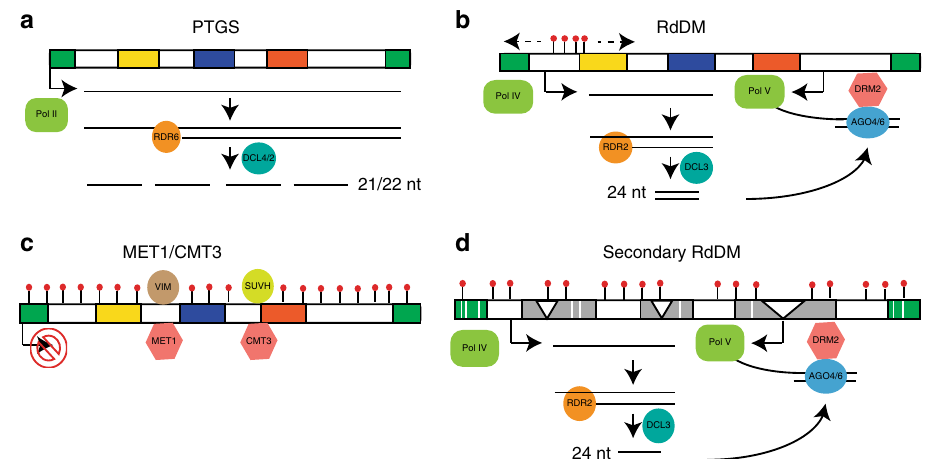
Fig. 5 Model of LTR silencing. a In early stages, LTR is transcribed by RNA Pol II. Post-transcriptional gene silencing (PTGS) is triggered with double- stranded RNA synthesis by RDR6 and afterwards 21-22nt sRNA generation by DCL4 and/or DCL2. b Along with increase of LTR copy number, 24nt sRNA is produced starting from certain region of LTR (gag for example) by RNA Pol IV, RDR2 and DCL3. These 24nt sRNAs are recruited into AGO4/6 which interact with DNA methyltransferase DRM2. By sequence pairing between 24nt sRNA and Pol V transcript, AGO-DRM2 complex function in cis to methylate LTR which is called RNA-directed DNA methylation (RdDM). RdDM then spreads to more regions of LTR. c After established by RdDM, DNA methylation is maintained by RNA-independent mechanism: CG methylation is maintained by VIM and MET1, CHG methylation is maintained by KYP/ SUVHs and CMT3. LTR is rarely transcribed. d Accumulated mutations in 5 ′ and 3 ′ LTRs and coding sequences (represented by white bars) together with TE re-insertion (represented by white triangles) make it less possible for LTR to transpose. At this stage, LTR is transcribed again and generates 24 nt sRNA, which mediates secondary